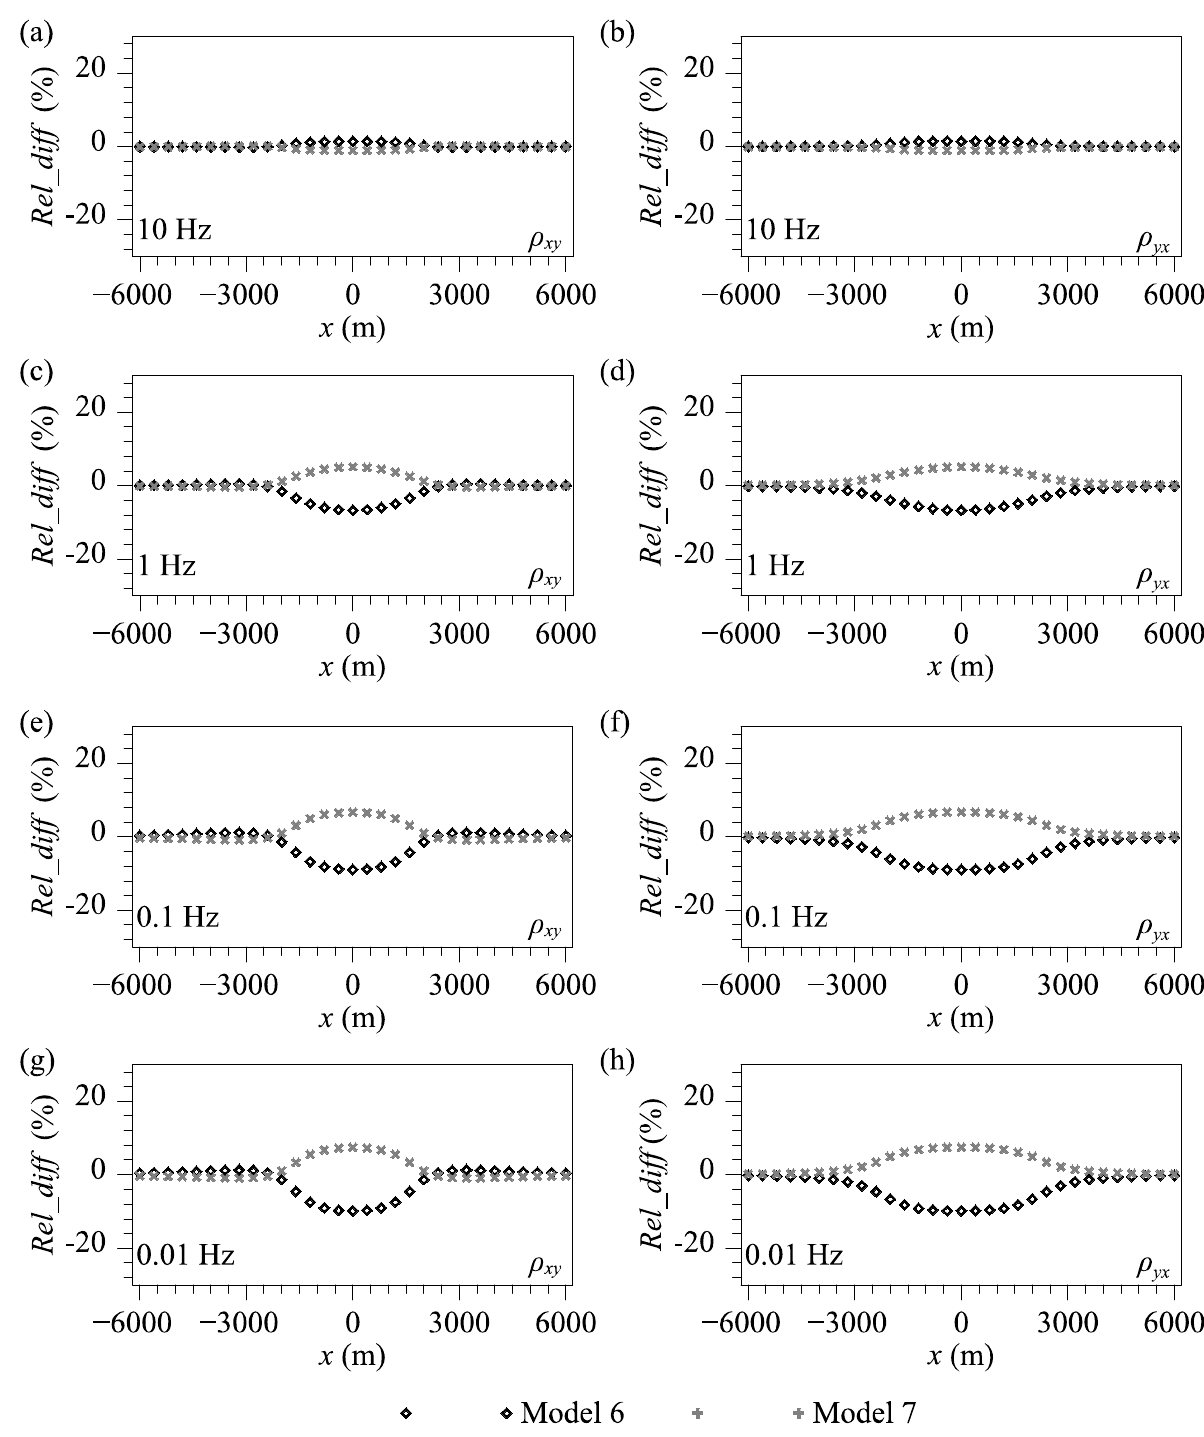
Figure 10. The relative differences between the apparent resistivities of Model 1, and Models 6 and 7. Models 6 and 7 are obtained by perturbing the smectite-illite-mixed-layer resistivity of Model 1 by 20% of its value. ( a , b ) are for 10 Hz, ( c , d ) are for 1 Hz; ( e , f ) are for 0.1 Hz, and ( g , h ) are for 0.01 Hz.